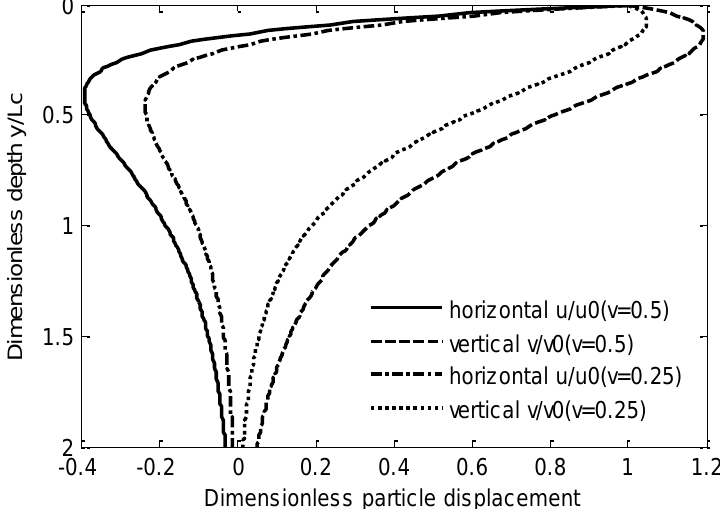
Figure 5. Distribution of particle displacement along with penetrating depth of surface wave (after Richart et al.